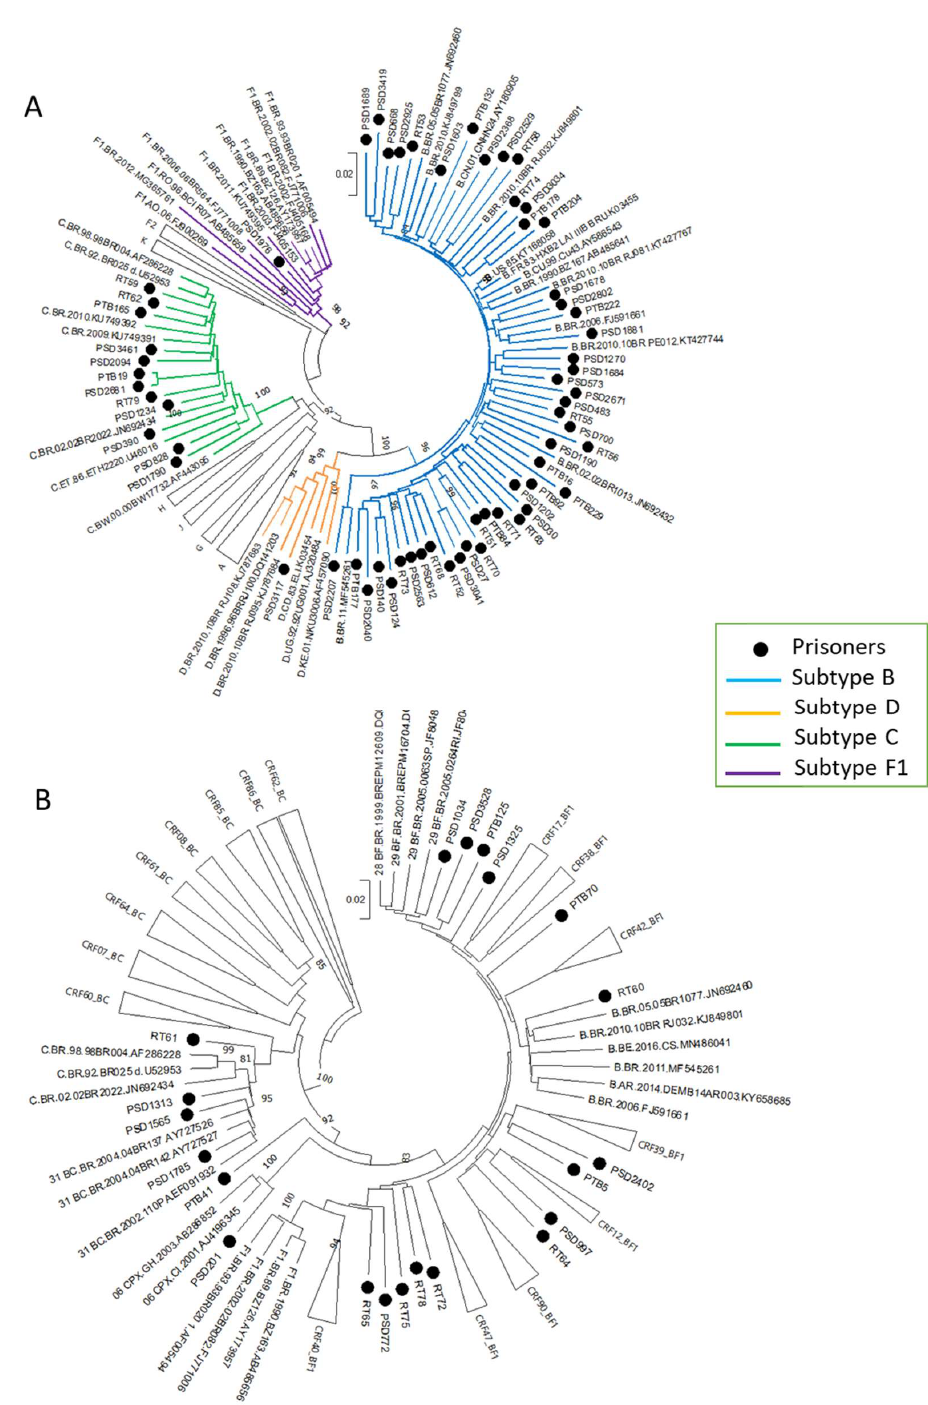
Figure 2. Neighbor-Joining (NJ) phylogenetic tree of 84 HIV-1 PR/RT sequences from prisoners from Mato Grosso do Sul, Central-West Brazil. The analyzed PR/RT alignment covered a fragment of 1261 bp, corresponding to nucleotides 2254 to 3514 relative to HXB2 genome. Sequences from this study are marked with a full circle. Bootstrap values are represented only if >80. ( A ) Pure HIV-1 subtypes, involving 120 HIV-1 PR/RT sequences and ( B ) Recombinant sequences, involving 96 HIV-1 PR/RT sequences.